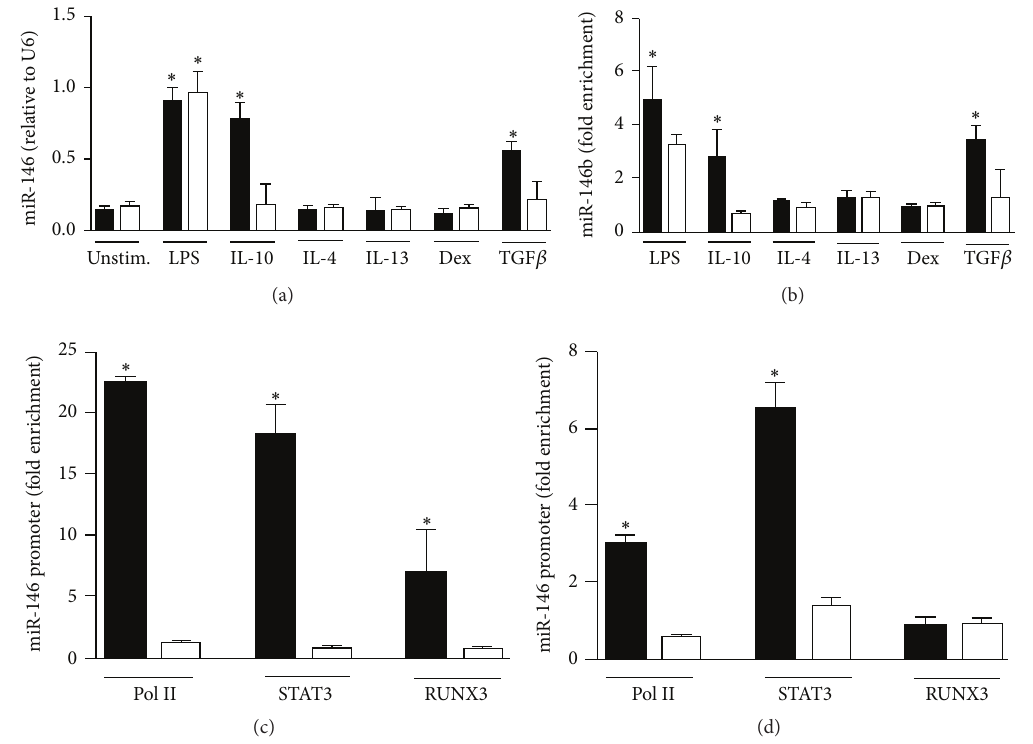
Figure 1: MiR-146b is induced in human monocytes by TGF 𝛽 signaling pathway . Human purified monocytes were stimulated for 24 h with 100ng/mL LPS, 20 ng/mL IL-10, 20 ng/mL IL-4, 20ng/mL IL-13, 20ng/mL Dex, or 50 ng/mL TGF 𝛽 and (a) miR-146b (black columns) and miR-146a (white columns) levels from total RNA were measured by qPCR in triplicate samples. (b) Cell extracts were subjected to RIP assay using anti-Ago2 or IgG control Abs and levels of miR-146b (black columns) and miR-146a (white columns) were measured by qPCR in triplicate samples. Results are expressed as fold change over control (mean ± SEM, 𝑛 = 3 ). (c-d) ChIP assays were carried out on human purified monocytes stimulated or not for 4 h with 50ng/mL TGF 𝛽 (c) or 20 ng/mL IL-10 (d) using anti-Pol II, anti-STAT3, or anti-RUNX3 antibodies. Q-PCR was carried out using specific primers for miR-146b (black columns) or miR-146a (white columns) promoters. Results are expressed as fold change over control (mean ± SEM, 𝑛 = 3